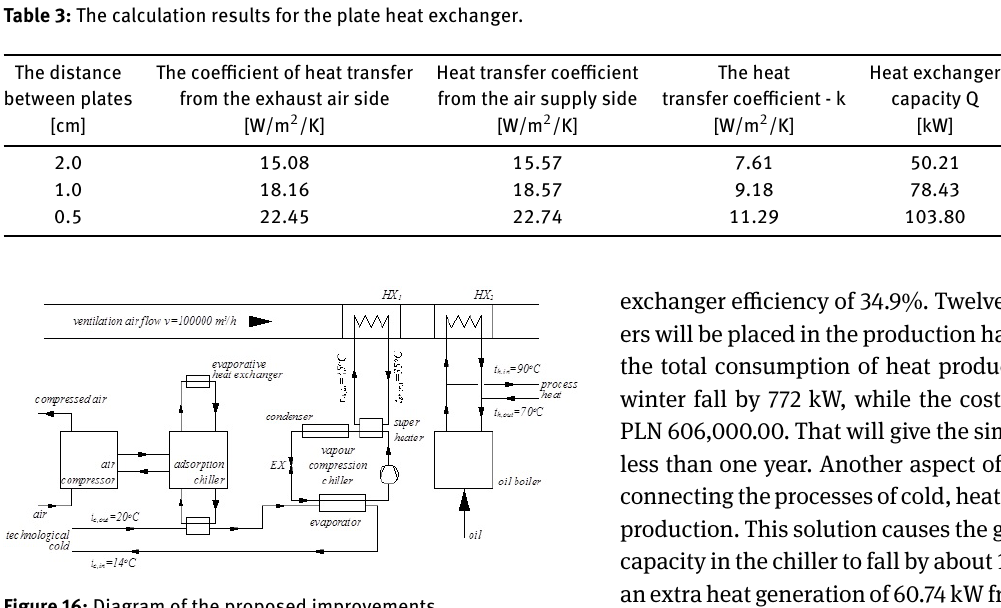
Figure 16: Diagram of the proposed improvements. Table 4: Summary of investment